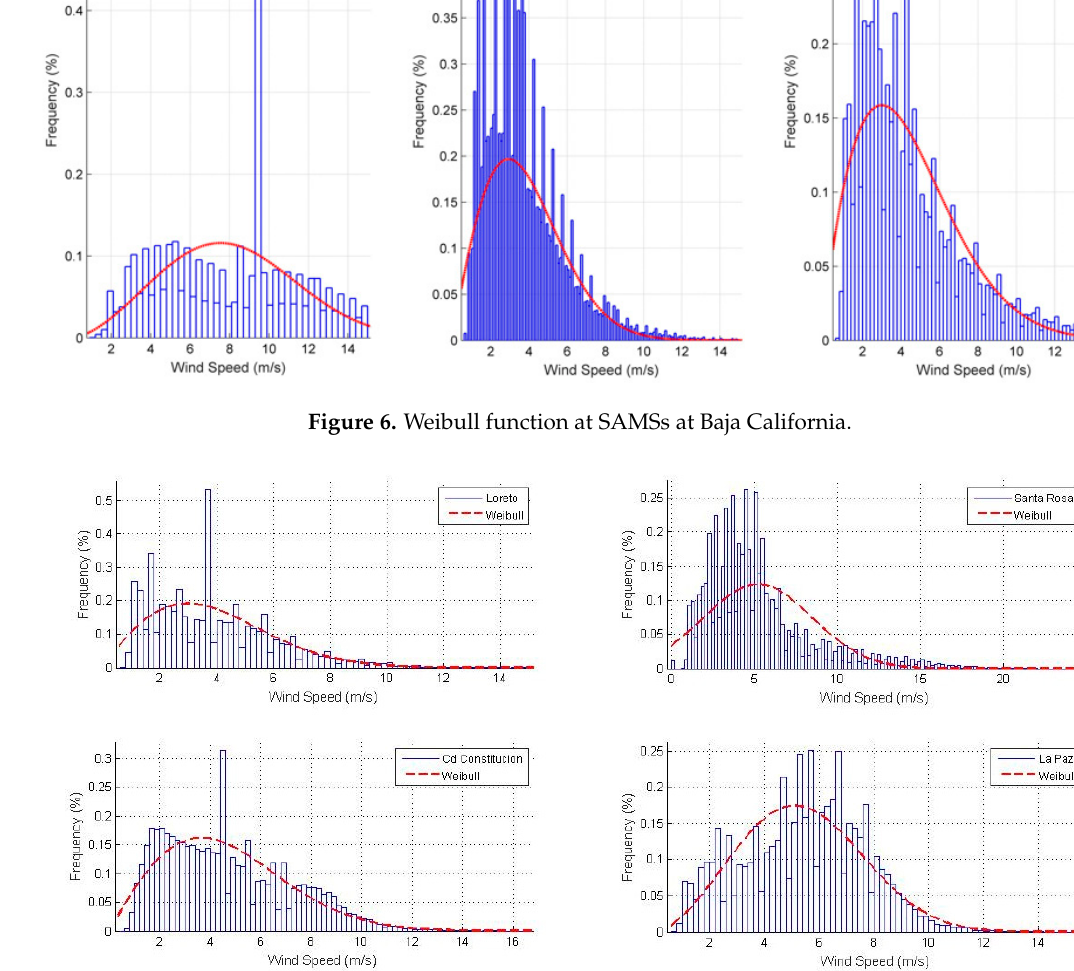
Figure 7. Weibull function at SAMSs at Baja California Sur.